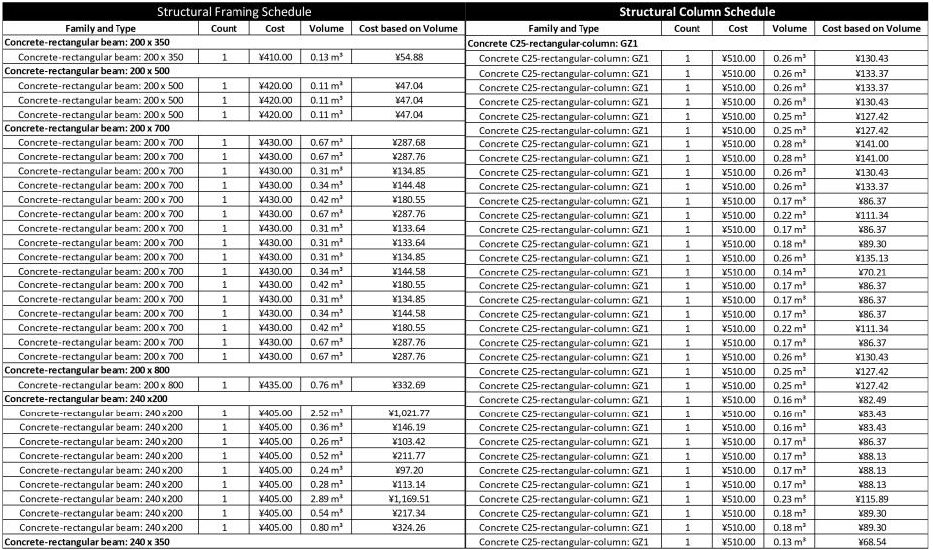
Figure 11. Sample of cost estimation report in Excel.